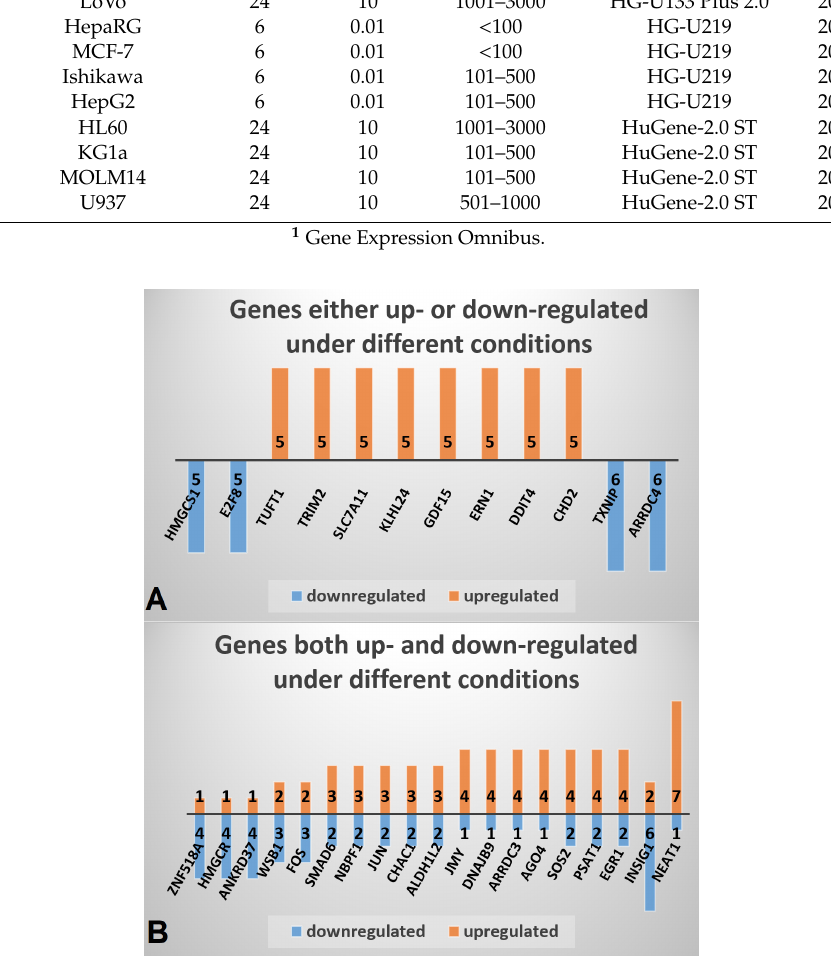
Figure 1. Genes most frequently differentially expressed under MTF treatment. The number of up- and/or down-regulated conditions is indicated at the frequency bars of each gene. ( A ) Genes either up- or down-regulated under different conditions. ( B ) Genes both up- and down-regulated under different conditions .